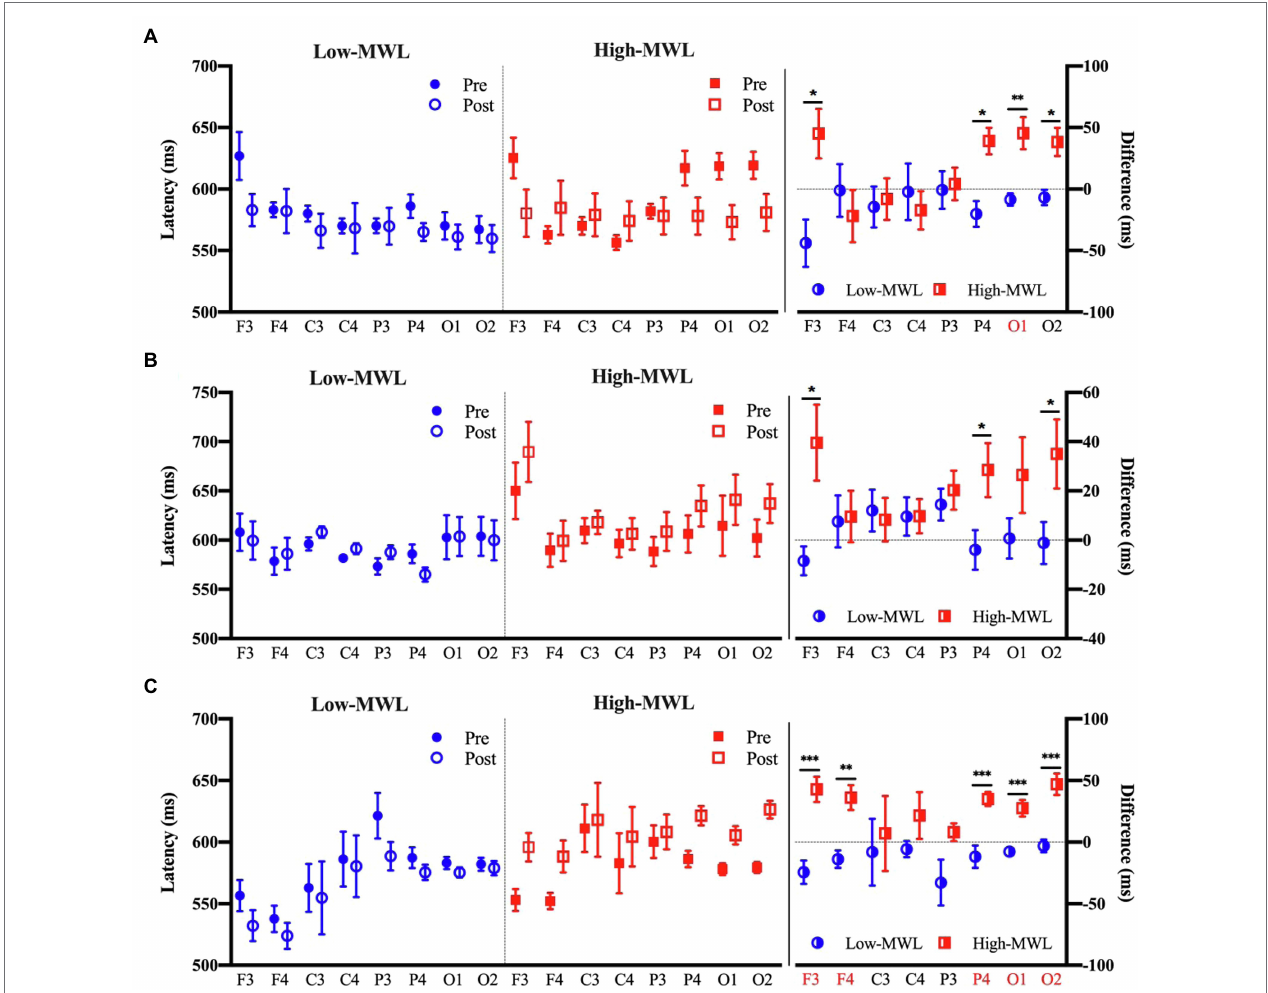
FIGURE 7 | Comparison of the P600 latency in ERP between the low- and high-MWL conditions. (A) ERP T condition. (B) ERP HEP condition. (C) ERP A-HEP condition (paired t-test; * p < 0.05, ** p < 0.0031, and *** p <